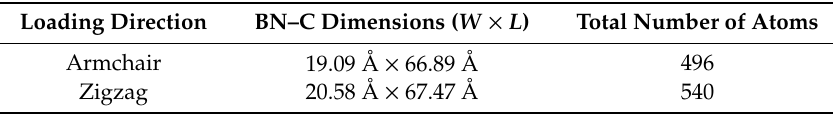
Table 1. Specifications of the BN–C nanosheet reinforcement.